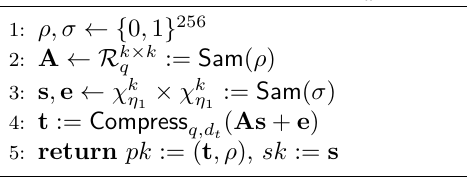
Algorithm 3 Kyber.CPA.KeyGen() Algorithm 5 Kyber . CPA . Enc ( pk, m